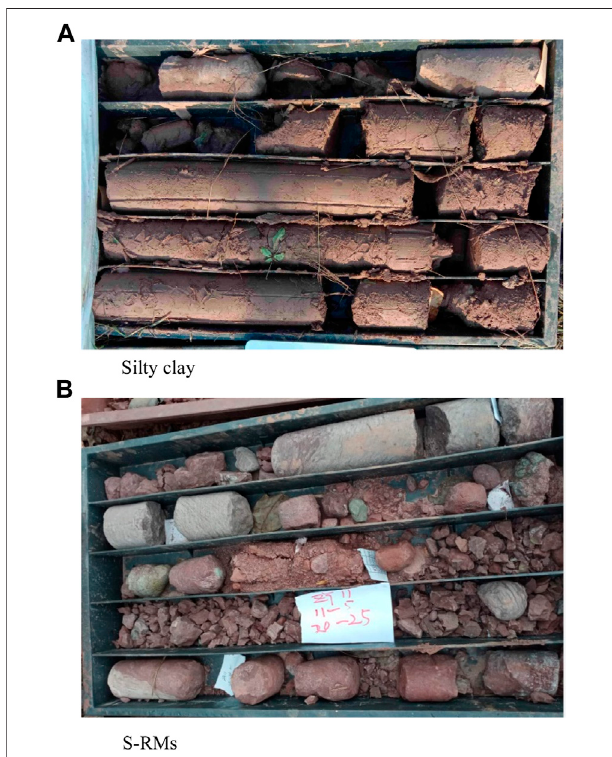
FIGURE 2 | Geomaterials of Tuanshiban landslide obtained by drilling. (A) Silty clay, (B) S-RMs.